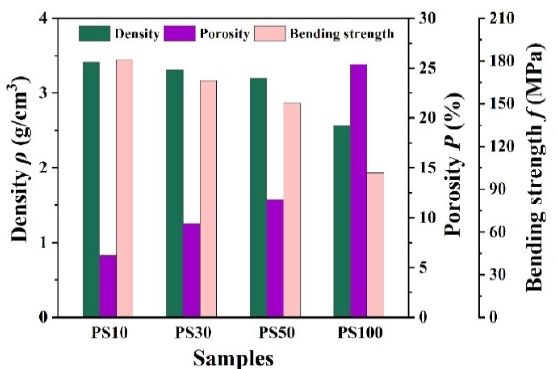
Figure 6. Density, porosity and bending strength of samples prepared by adding PS with different specifications.